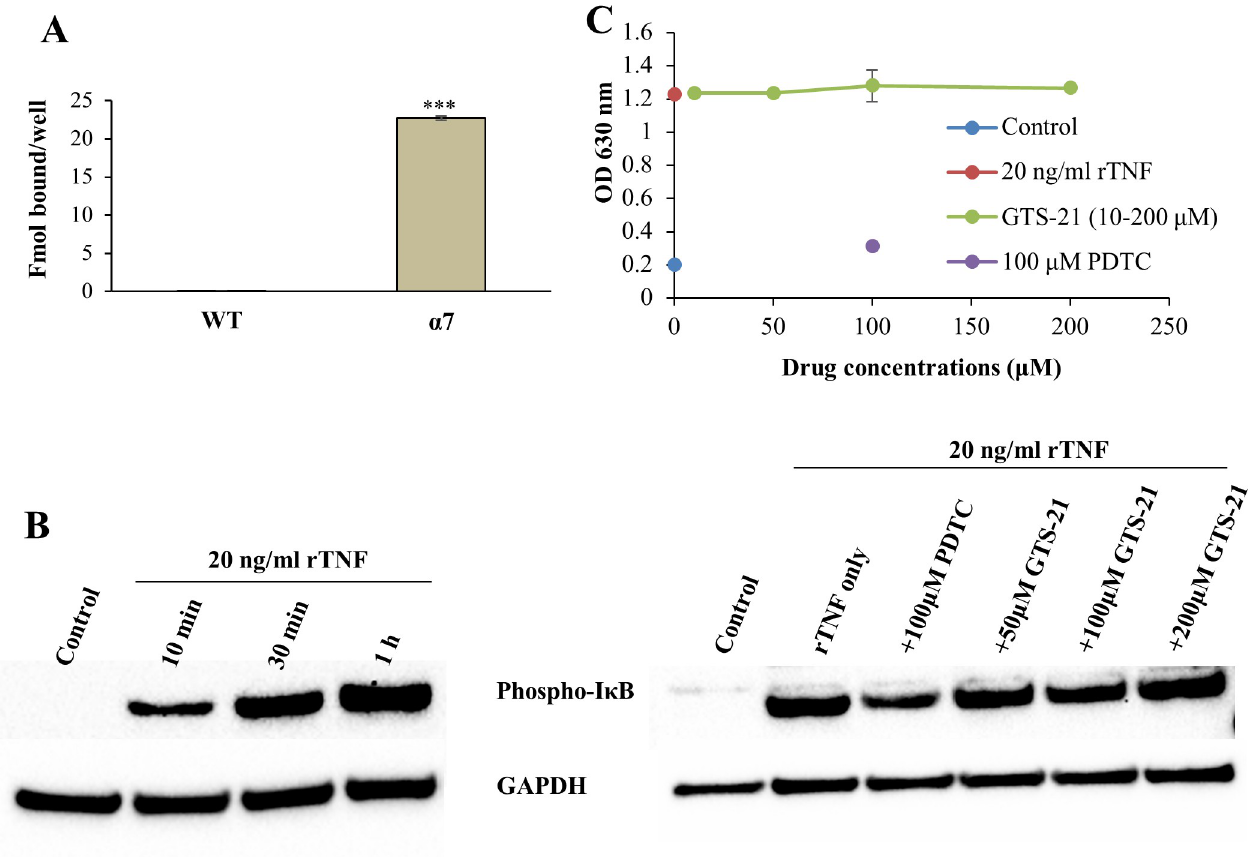
Fig 1. α 7 nAChR expression and GTS-21 stimulation do not block TNF-induced NF κ B-mediated signaling in GH4C1 cells. (A) 125 I- α BGT binding to WT GH4C1 cells compared to α 7 nAChR transfected cells ( α 7). Concentrations and error bars are as described in methods. ��� P < 0.0001 compared to WT. (B) Left: Western blot data showing a time-dependent TNF-induced I κ B phosphorylation levels. Right: Different concentrations of GTS-21 added 30 min prior to a 1 h TNF exposure (20 ng/ml), had no effect on pI κ B levels in α 7 nAChR transfected GH4C1 cells. In contrast, the NF κ B blocker PDTC decreased the levels of pI κ B. GAPDH is the loading control. (C) Effects of different concentrations of GTS-21 on TNF-induced SEAP. PDTC, an NF κ B inhibitor, blocked TNF-induced SEAP, confirming that inflammatory signaling is intact in GH4C1 cells and that these cells can be used to study NF κ B-mediated signaling. GTS-21 was unable to block TNF-induced SEAP in GH4C1 cells transfected with α 7 nAChR and NF κ B-SEAP plasmids.